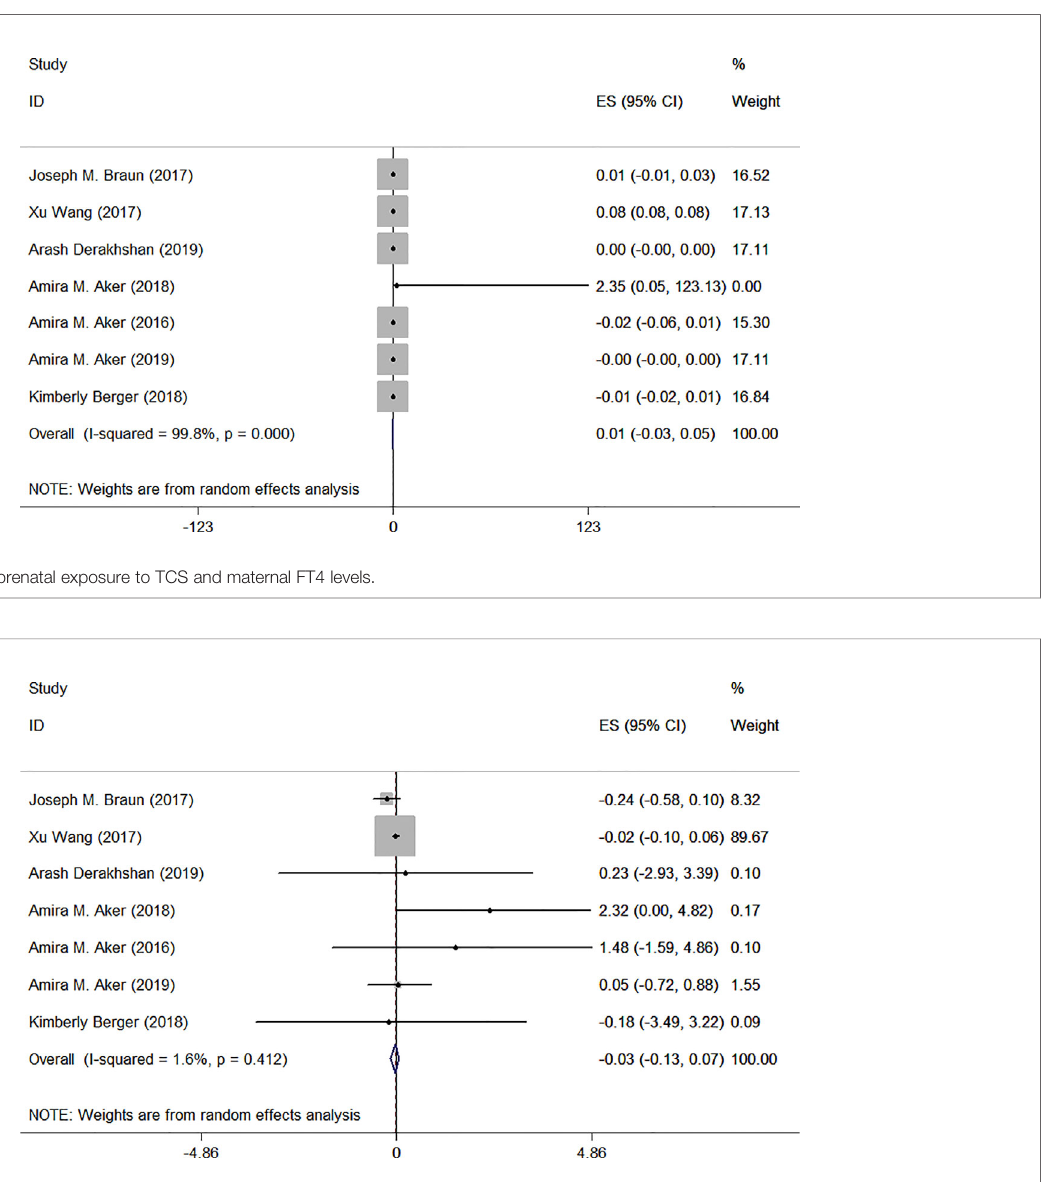
FIGURE 3 | Forest plot of prenatal exposure to TCS and maternal TSH levels.